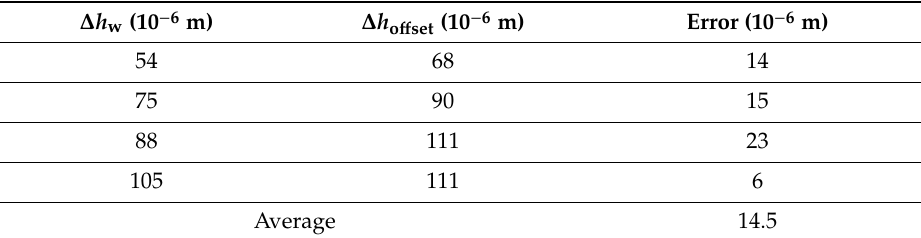
Figure 8. Result from dry-wet cyclic condition with ACSSM in 83 days after moving-average analysis and applying the offset value. The green line with double arrows indicated the differences of the last four dataset collected from the ACSSM and specimens. Table 1. Error calculation between ACSSM and test